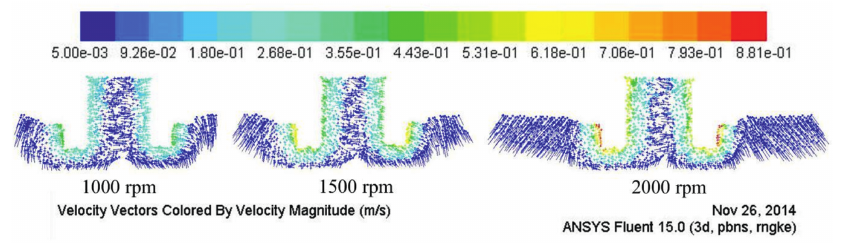
Figure 14: High-speed areas using different rotational speeds.